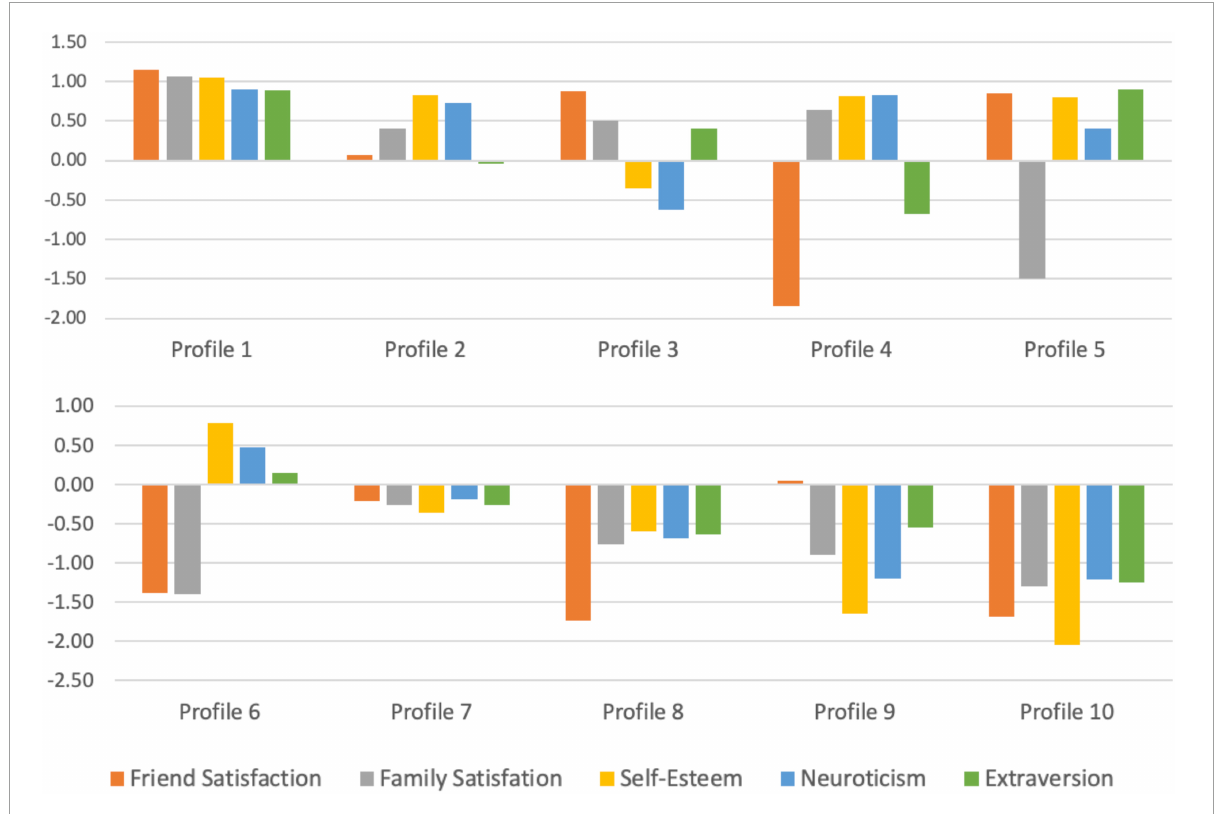
FIGURE1 Relationship, self-esteem, and personality patterns for each profile. Standardized means for predictor variables used in latent profile analysis by profile, ordered from most happy profile (Profile 1) to least happy profile (Profile 10). For ease of interpretation, neuroticism is reversed so positive means indicate lower levels and negative means indicate higher